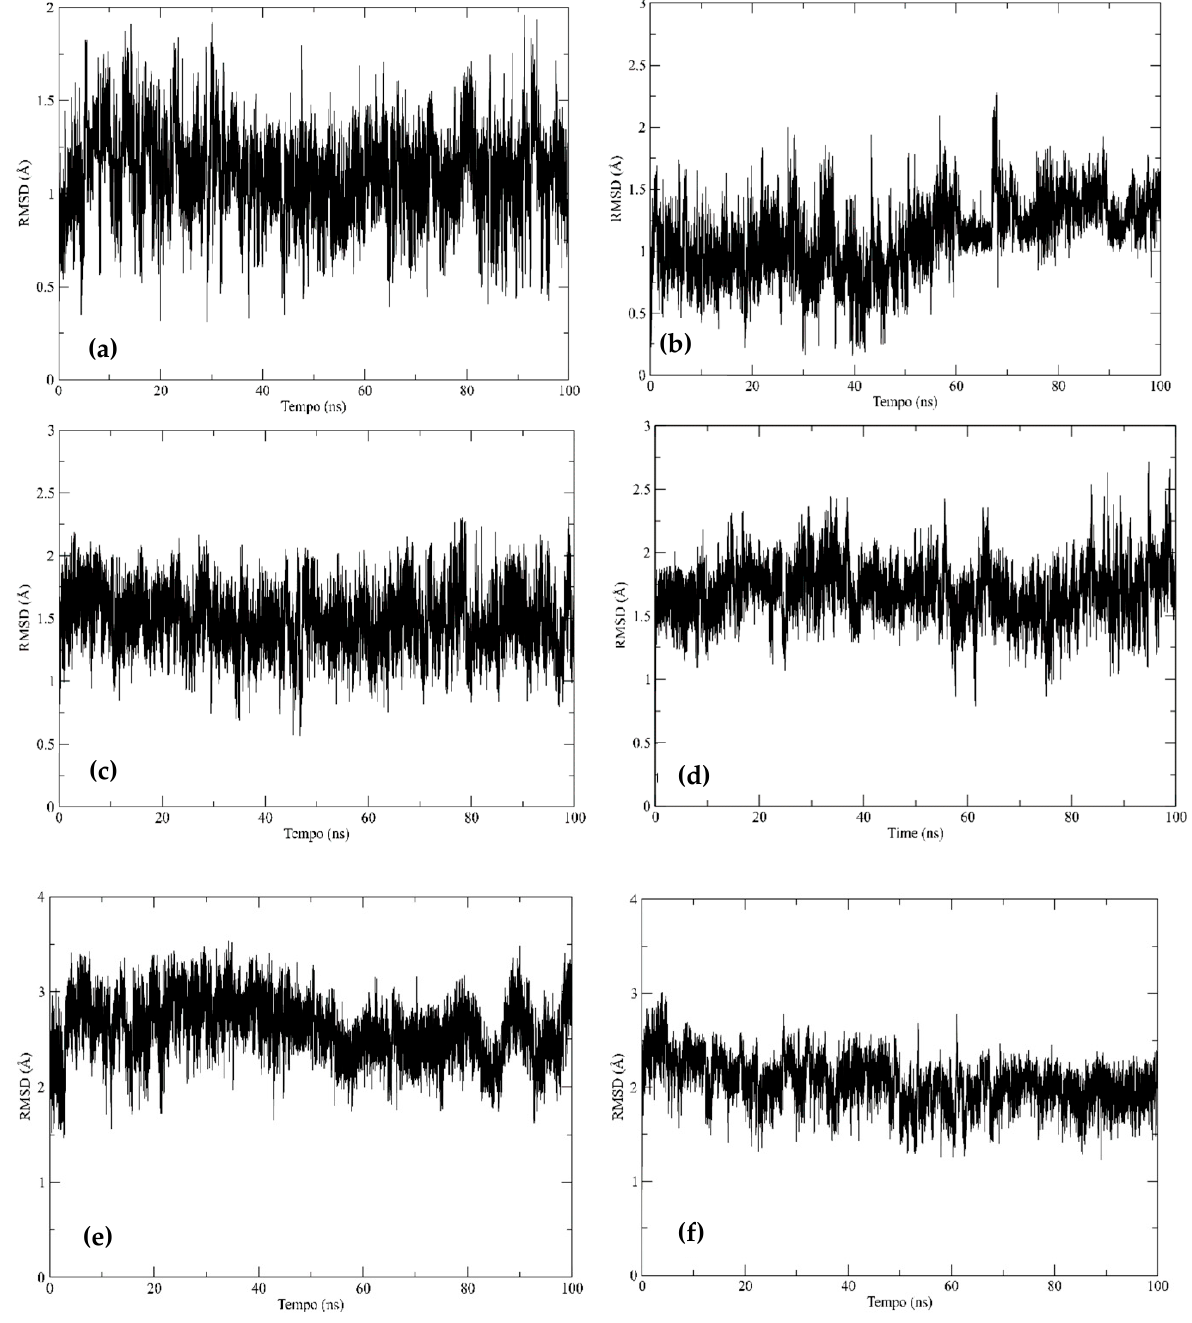
Figure 5. Square Root of Mean Square Deviation ( RMSD ) of the initial conformation of the complex versus the simulation time (ns) in the production stage. ( a ) Octanoic acid; ( b ) Decanoic acid; ( c ) Dodecanoic acid; ( d ) Tetradecanoic acid; ( e ) Hexadecanoic acid; ( f ) cis -9-octadecenoic acid.